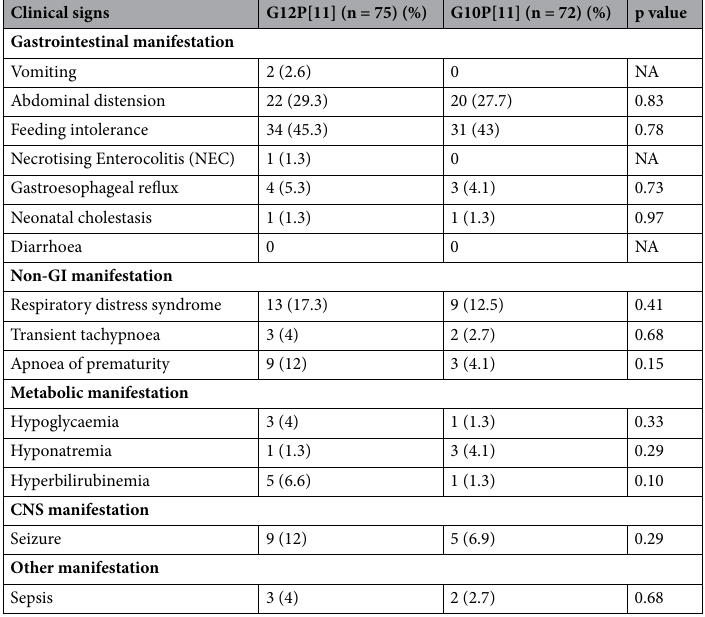
Table1. Clinical conditions of RV infected neonates with RV predominant strain. Pearson’s Chi Square ( χ 2 ): 9.120, n = 147, α-0.05, one tailed, Cumulative p-value: 0.764. NA-Not applicable, Clinical correlation of leading genotypes during study period (Sep 2016–Nov 2019) with GI manifestation and non-GI